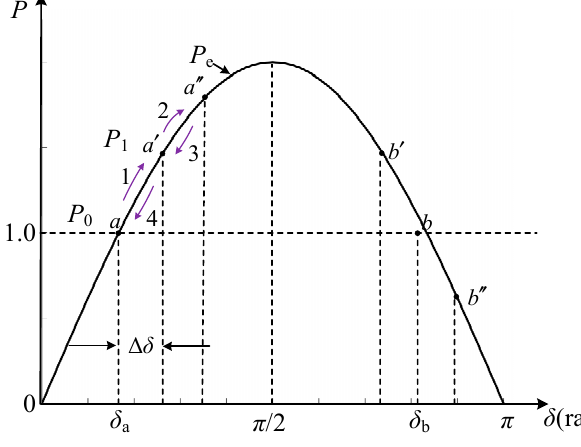
Figure 5. Power angle curve of the equivalent SG.